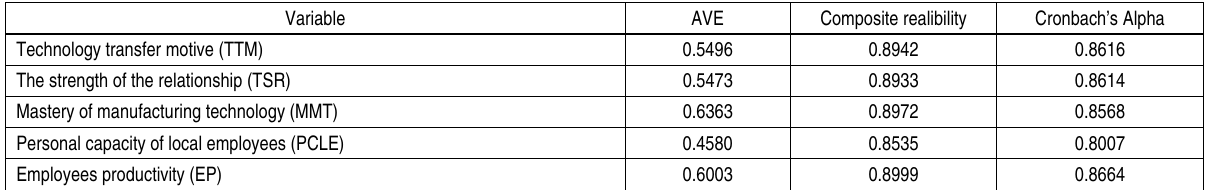
Table 1. Outer model, discriminant validity and composite reliability Variable